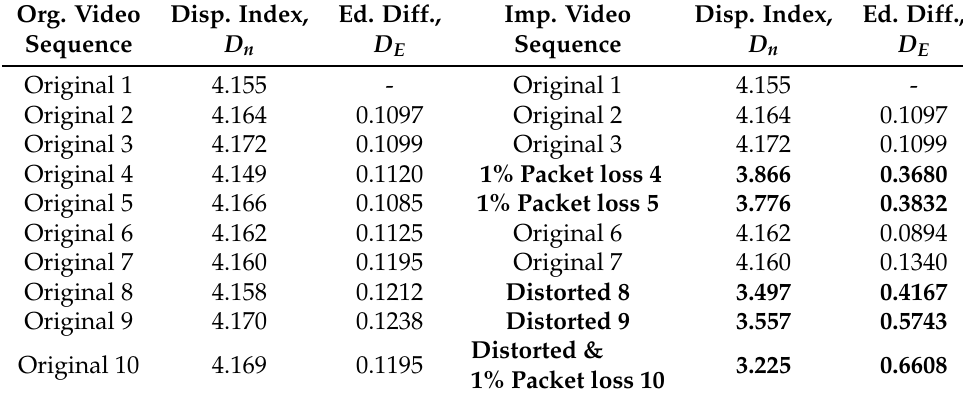
Table 2. Experimental analysis of the Bicycle Riding